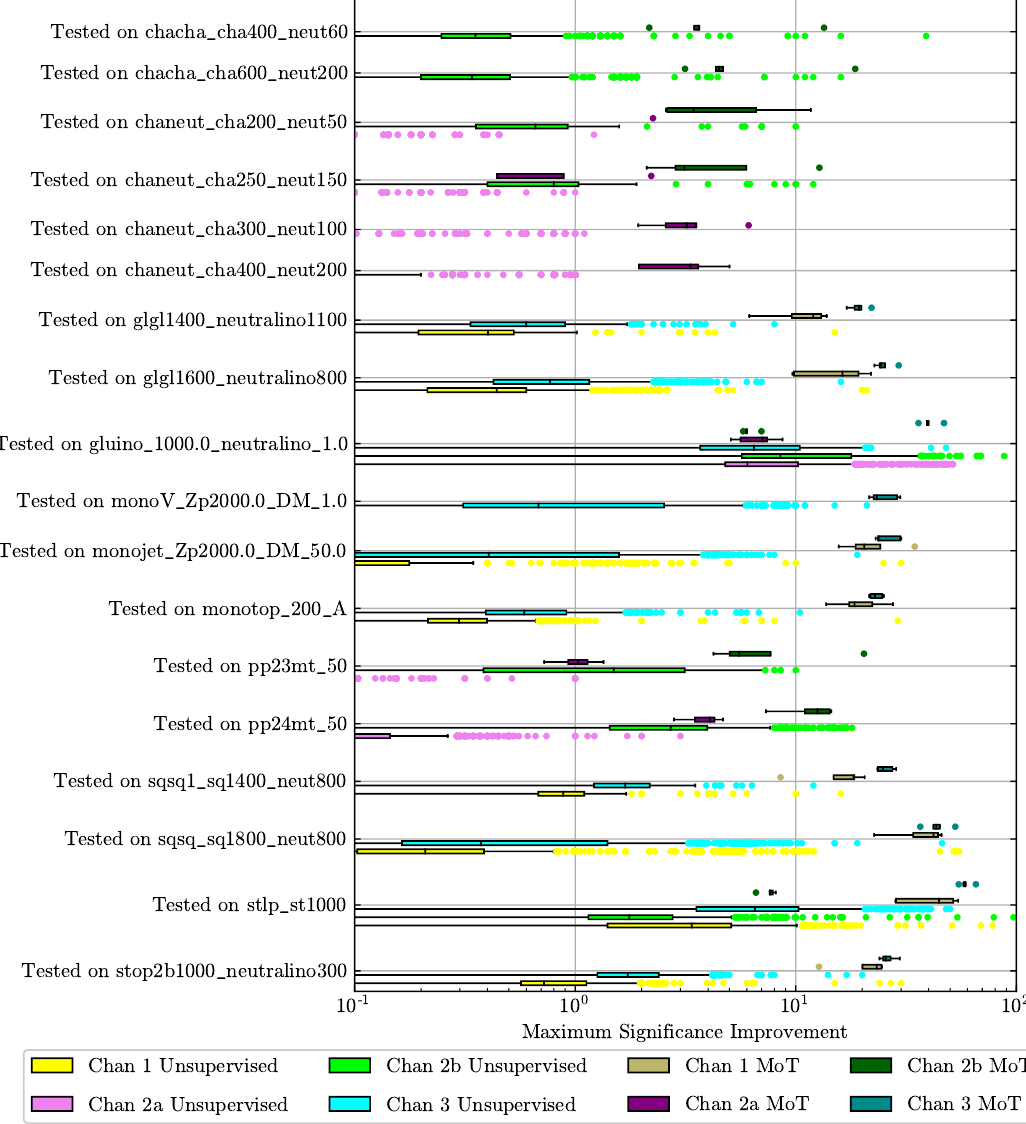
Figure 10 . The figure shows the results for the maximum significance improvements comparing the supervised methods trained from a mixture of theories (above the central line) and the unsupervised methods (below the central line). Chan X Unsupervised denotes the results for channel X from unsupervised methods, while Chan X MoT denotes the results for channel X from supervised methods. For each individual channel, the ML models above the central line correspond to the 5 endpoints of the dashed lines in figures 1, 5, 6 and